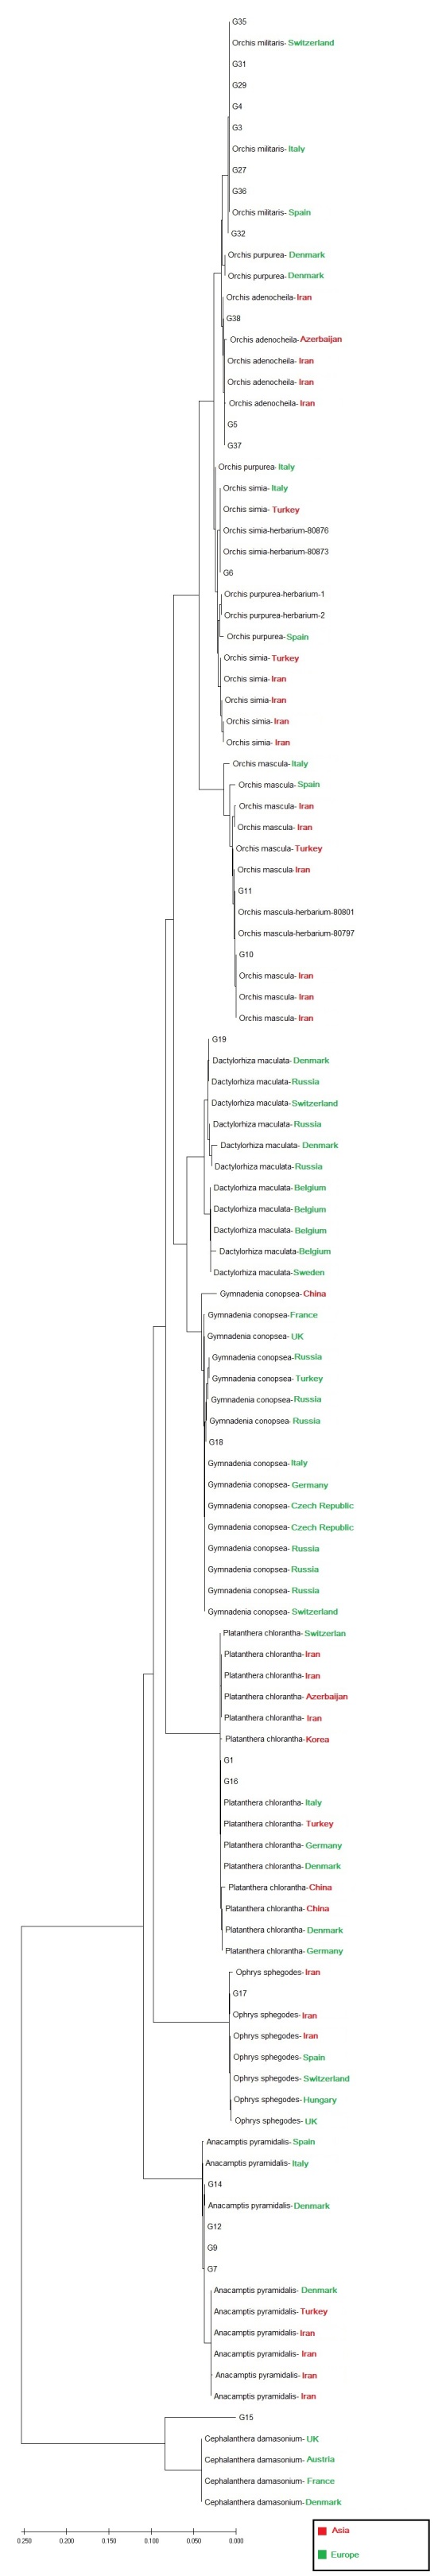
Neighbour-joining phylogenetic tree, based on ITS sequences of selected orchids with geographic origins (green: Europe; red: Asia) as inferred from Suppl. material 7.